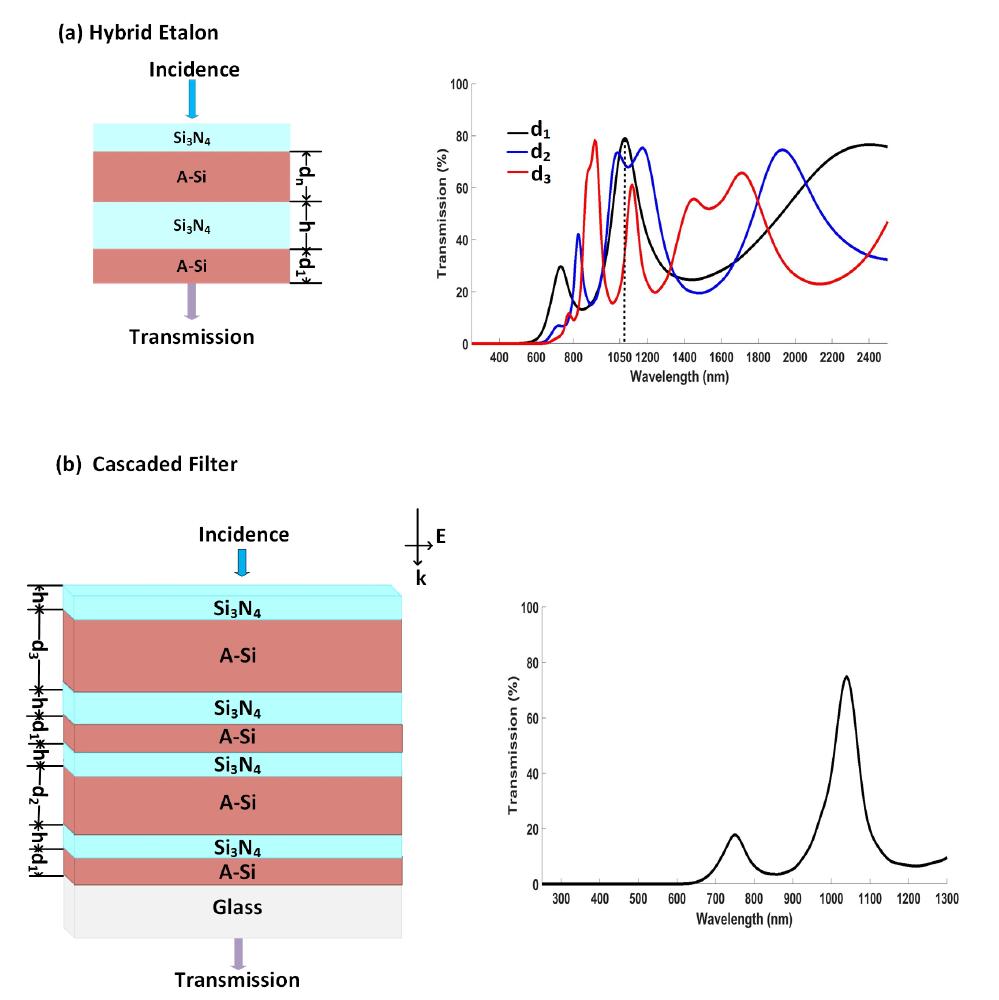
Figure 4. ( a ) Schematic of hybrid etalon and its transmission spectrum at different cavity thicknesses such that d n = d 1 , d 2 , and d 3 , where d 1 = d = 80 nm is the fundamental cavity thickness, while d 2 and d 3 are its multiples; ( b ) schematic of multilayered thin-film cascaded filter and transmission spectrum of its theoretical and experimental results, where d 1 = d = 80 nm is the fundamental thickness of cavity, while d 2 and d 3 are its multiples.